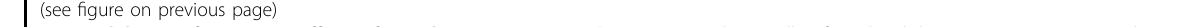
the absence of MG132. MG132 treatment caused EHF-SF protein levels to increase slightly likely due to upregula- tion of its mRNA levels (Fig. S3C). Based on the fi nding that endogenous EHF-SF was easily detected by IB ana- protein is more stable in the nucleus than EHF-LF.